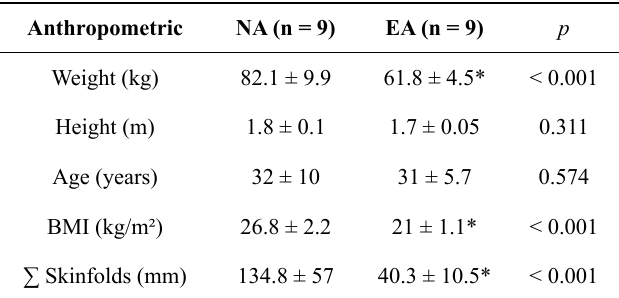
Table 1- Anthropometric characteristics in the EA and NA groups, street